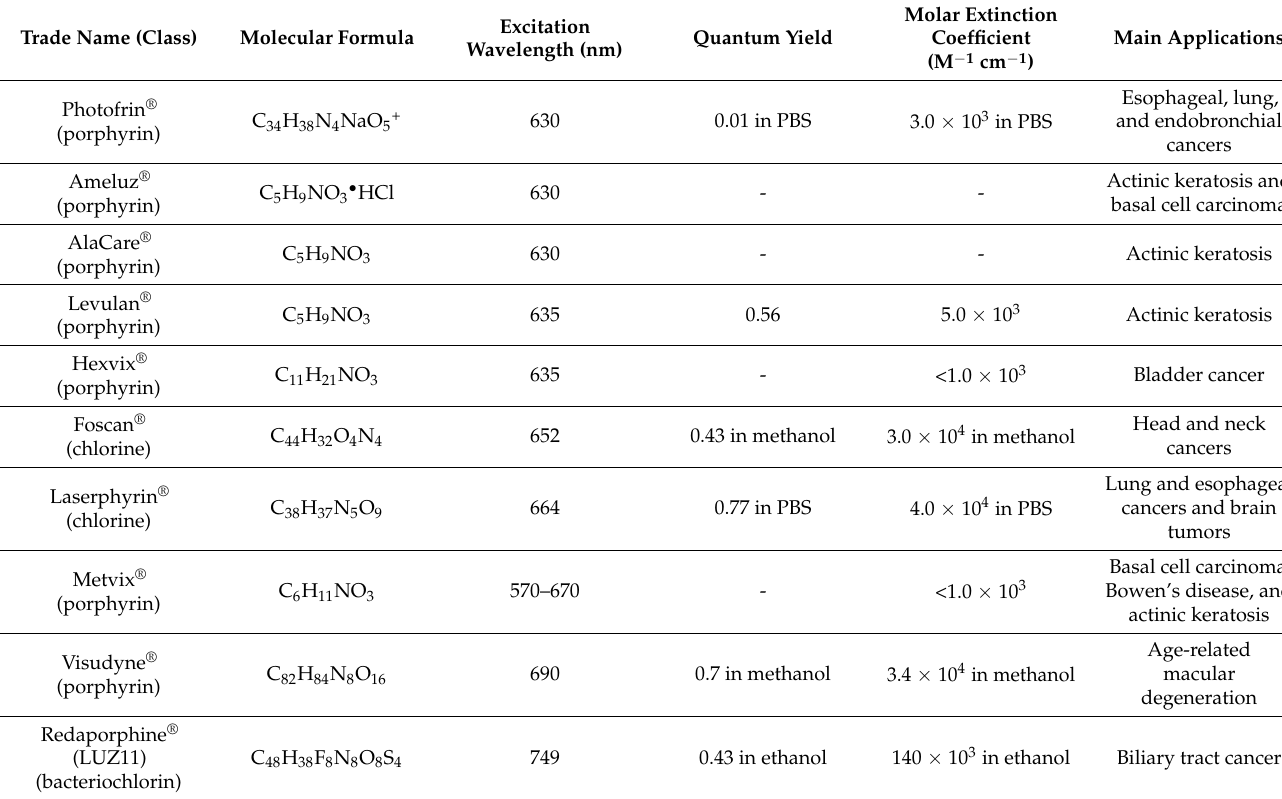
Table 1. Photosensitizers used in clinical PDT.